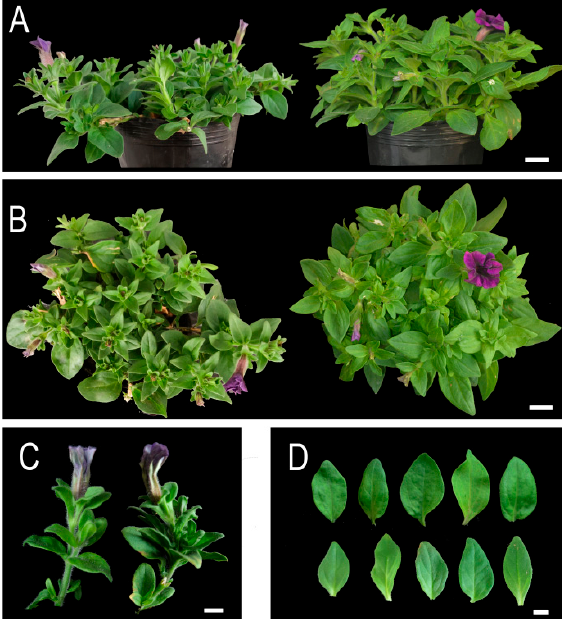
Figure 3. Plant phenotype of PhSK -silenced petunia vegetative organs. ( A ) Four-week-old control plant ( left ) and PhSK -silenced plant ( right ). ( B ) The vertical view of the 4-week-old control plant ( left ) and PhSK -silenced plant ( right ). ( C ) Internodes of the control plant ( left ) and PhSK -silenced plant ( right ). ( D ) Leaves of the control plant ( top ) and PhSK -silenced plant ( bottom ). ( A , B ) Bar = 2 cm, ( C , D ) bar = 1